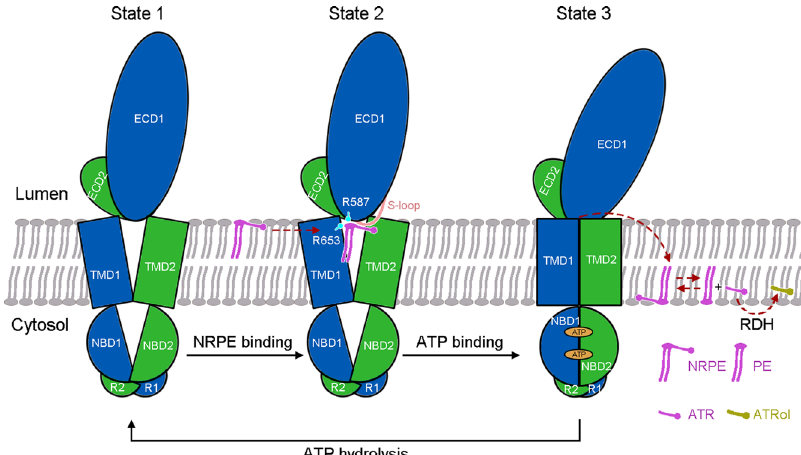
Fig. 6 A working model of ABCA4-mediated NRPE translocation. Schematic illustration of the ‘ lateral access and extrusion ’ cycle of ABCA4 inferred from the three resolved structures. The two halves of ABCA4 are colored marine and green for half 1 and half 2, respectively. In the absence of ATP, the TMDs exhibit a V-shaped lateral-opening conformation, allowing the lateral access of the NRPE substrate from the luminal membrane lea fl et. ATP binding transmits the TMDs to a closed conformation, which might extrude the NRPE from luminal lea fl et to cytoplasmic lea fl et followed by NRPE hydrolysis and retinal dehydrogenase (RDH)-mediated ATR reduction to ATRol. ATP hydrolysis resets the transporter to the lateral-opening conformation ready for next transport cycle. See text for discussion of the proposed working